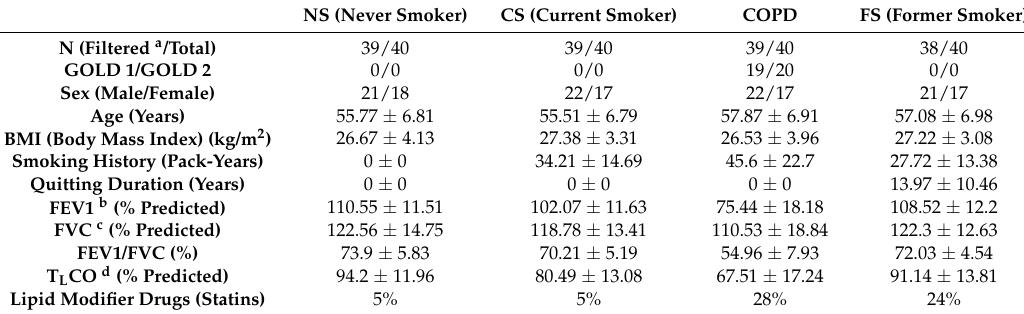
Table 1. Summary statistics of the analyzed study population. Data presented are mean ± standard deviation (SD). The values are for the samples that passed the lipidomics quality control (“filtered”, see methods). The percentage of each group using lipid modifier drugs (all statins) is included. NS (Never Smoker) CS (Current Smoker) COPD FS (Former Smoker) N (Filtered a /Total)